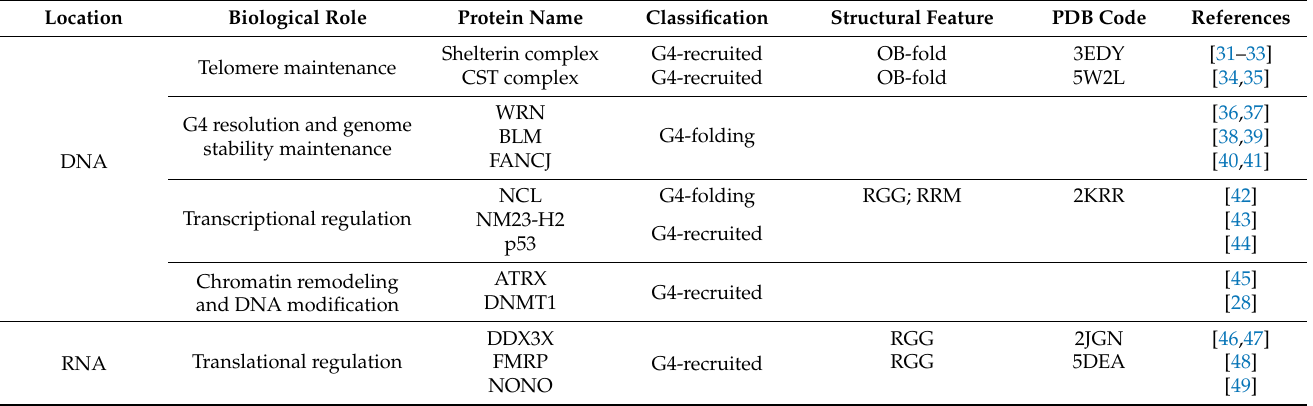
Figure 2. Location and biological functions of G-quadruplex-binding proteins. According to their location, G4BPs can be classified into the following two categories: DNA and RNA G4BPs. In cells, G4BPs perform various biological functions. 1 (cid:13) At telomeres, telomere-binding proteins form a ternary complex with the G4 structures of telomeric DNA for telomere maintenance. 2 (cid:13) G4s formed during replication present obstacles to the replication machinery and should be resolved by helicases for effective replication. Meanwhile, DNA repair proteins could be recruited to G4 sites to repair DNA double-strand breaks (DSB). 3 (cid:13) In terms of epigenetic control, the inactivation of DNA methyltransferase 1 (DNMT1) when binding G4s results in hypomethylation at CpG islands. 4 (cid:13) In the promoter regions, multiple transcription factors can bind G4s upstream of the transcription start site (TSS) and activate gene transcription. RNA G4BPs regulate mRNA maturation including mRNA export and splicing, and they also function in translational control. Table 1. In this table, several key G4BPs with different biological functions are summarized. Their location, classification and structural features (if any) are